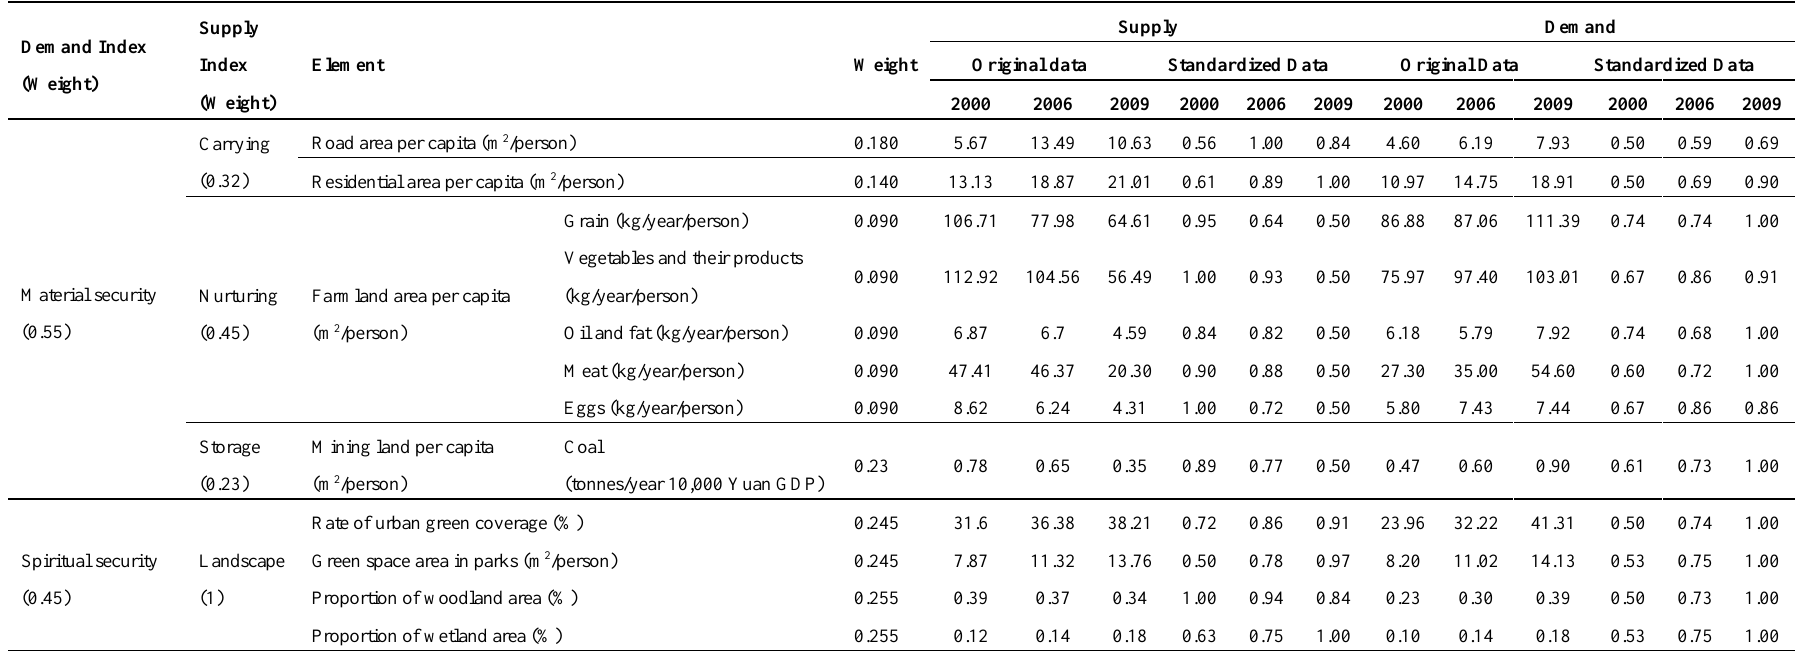
Table 4. Evaluation factors and weights of land ecological security in